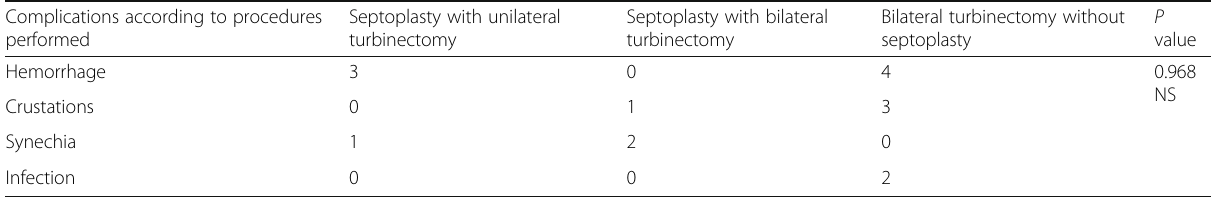
Septoplasty with unilateral turbinectomy